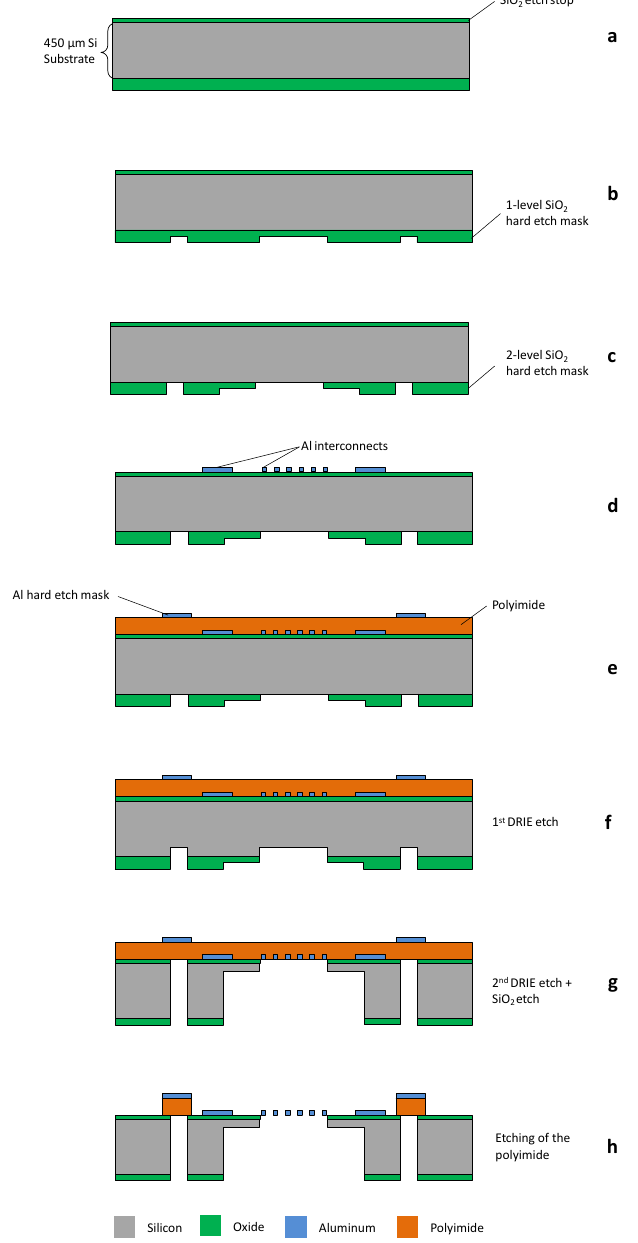
Figure 3. Cross-sectional view of the fabrication flow of the test